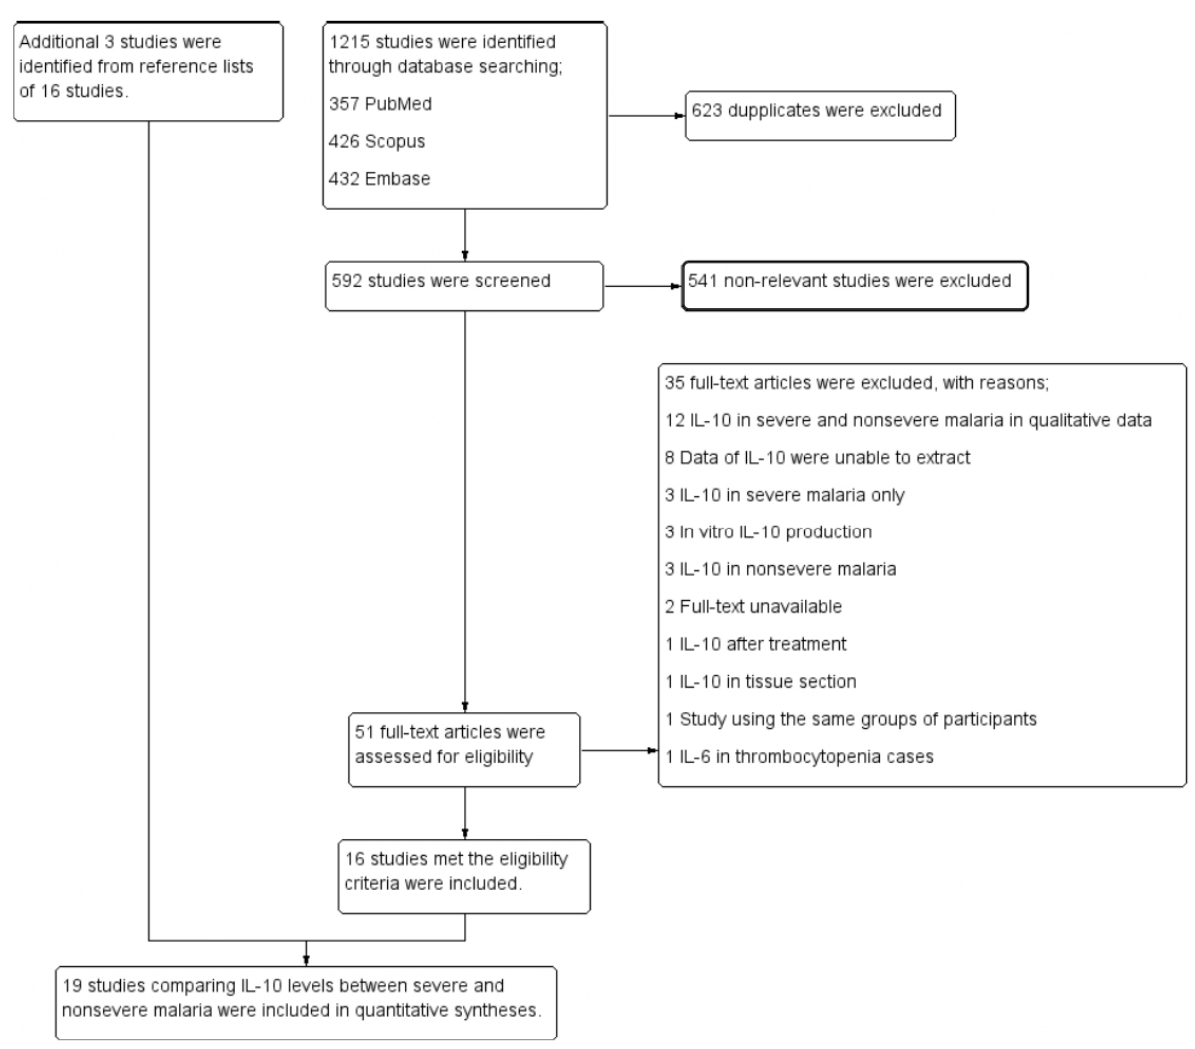
Figure 1. Flow diagram illustrating the selection of pertinent studies.